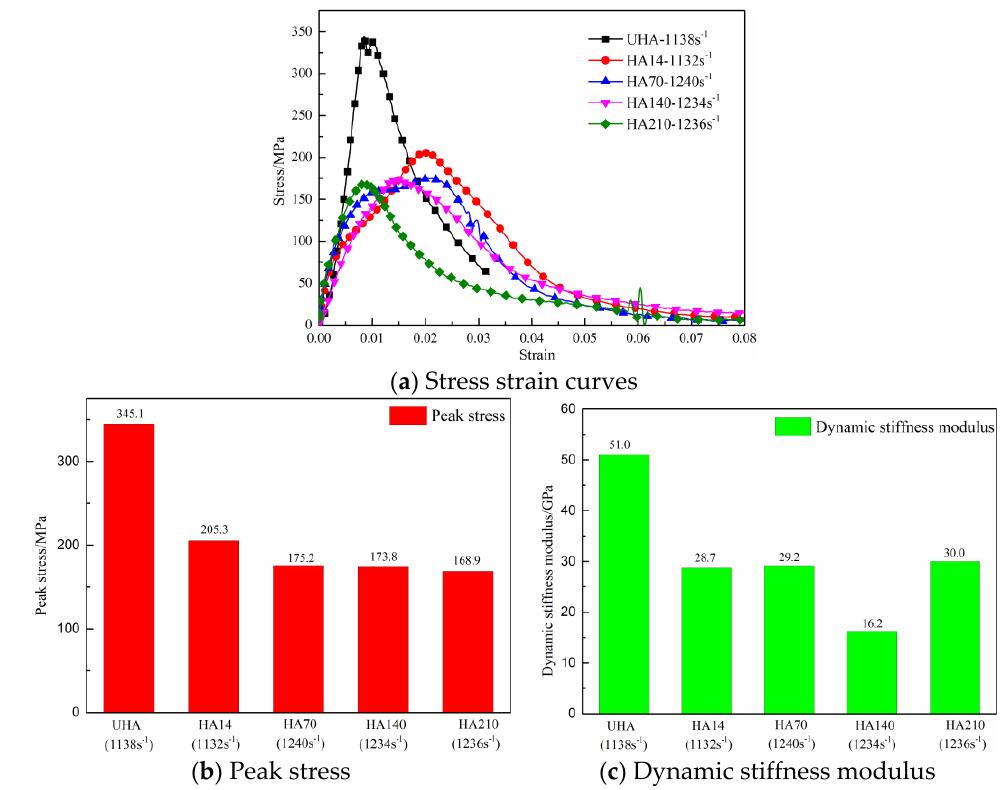
Figure 16. The effect of cyclic hygrothermal aging on the dynamic compressive properties under 1100~1250 s − 1 , ( a ) Stress strain curves, ( b ) Peak stress, ( c ) Dynamic stiffness modulus.